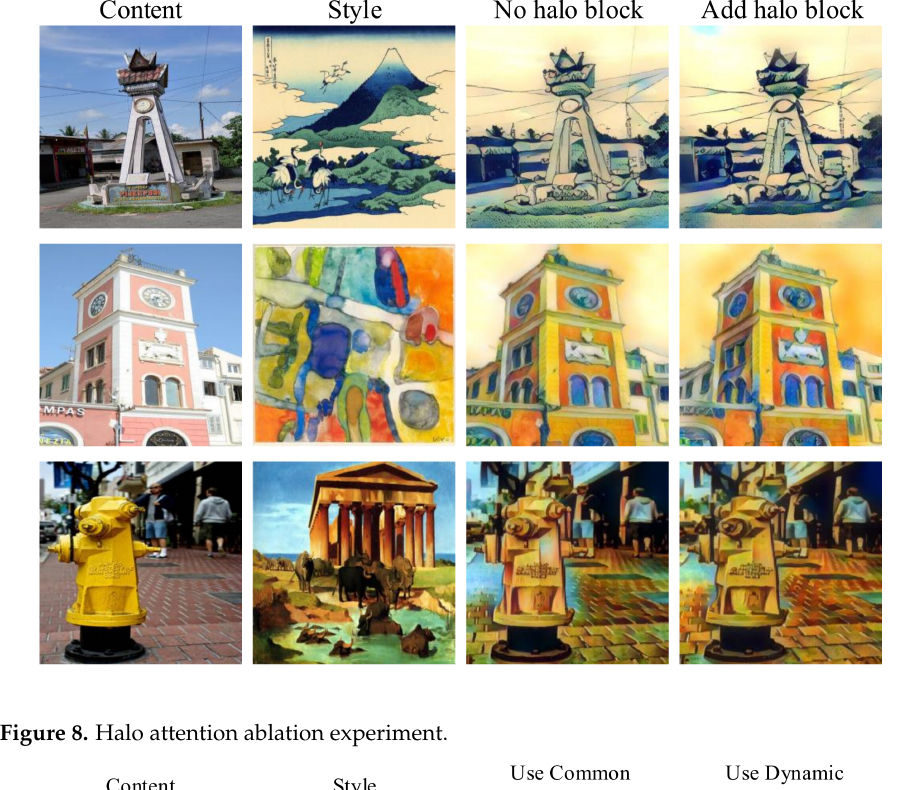
Figure 8. Halo attention ablation experiment.